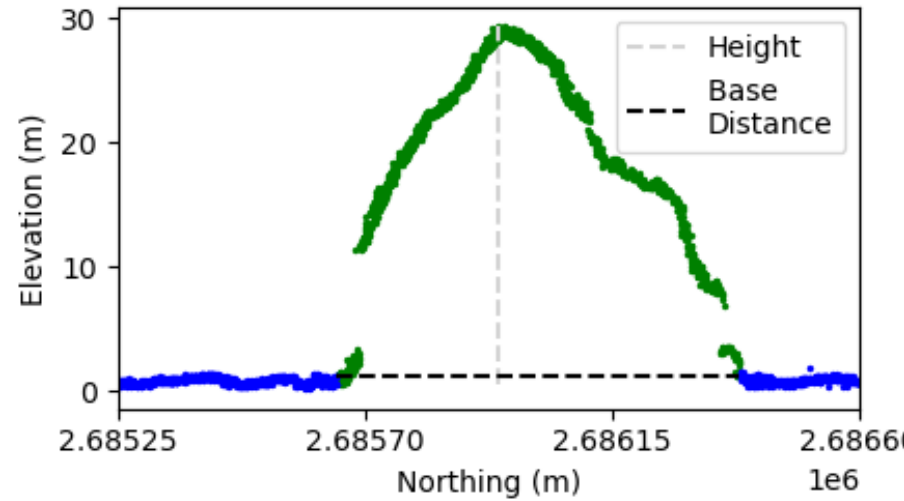
Figure 2. Example of physical extents (maximum height and base horizontal distance) metric calculation using ICESat-2 manually-labeled ground photons and the orthorectified elevations that allow for sub-meter tracking of volcanic deposits over time as an advantage to stereo-only digital elevation model (DEM) observations.